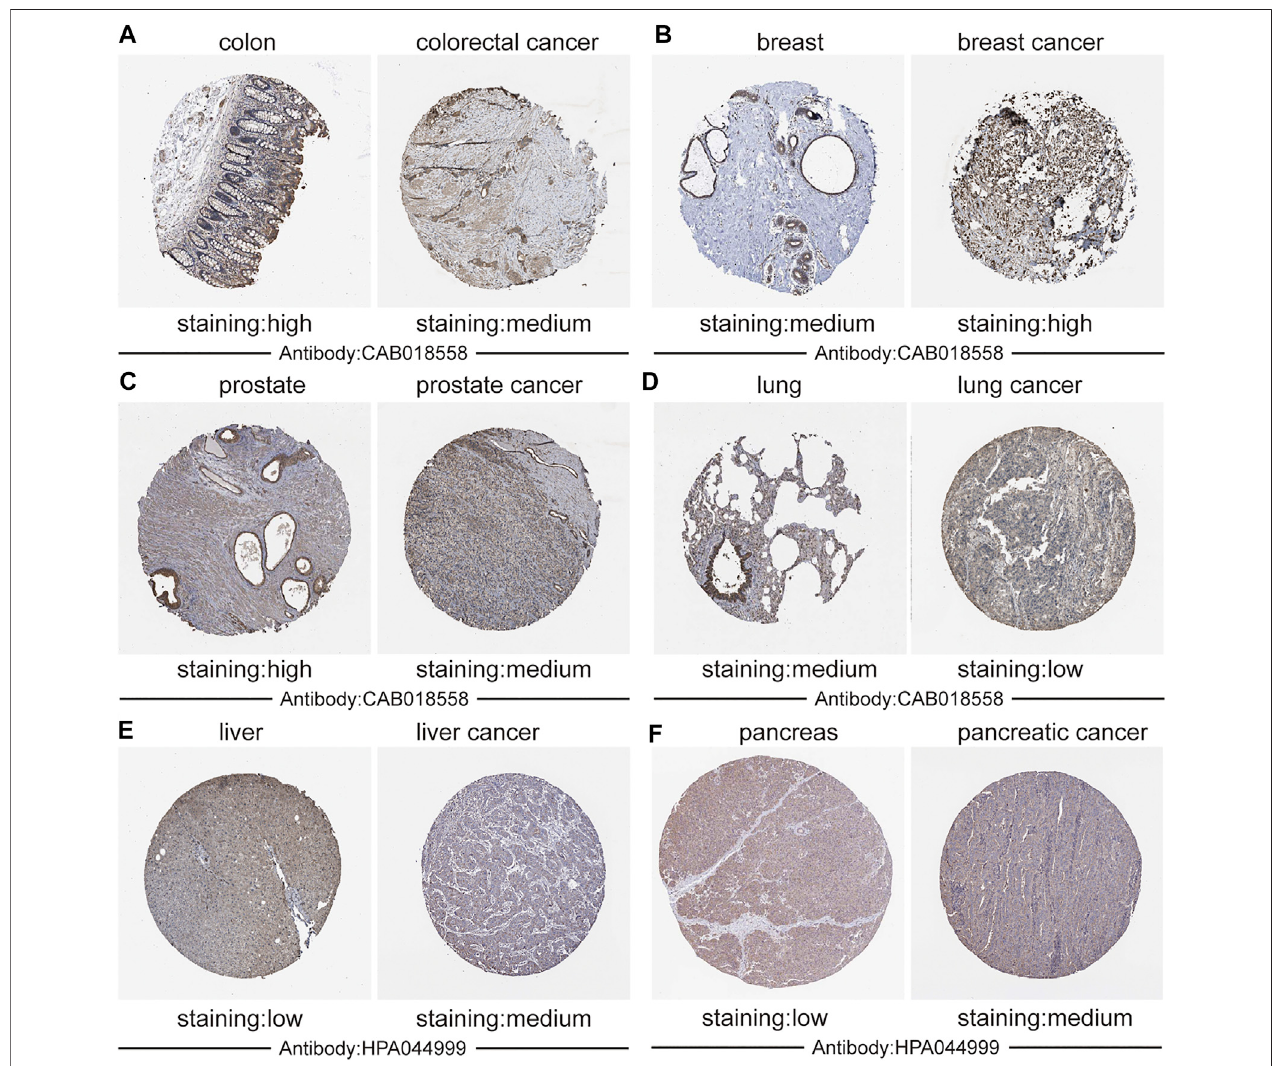
FIGURE 2 | Validation the expression of CALM1 on translational level using immunohistochemistry from the Human Protein Atlas database. (A) Colon and colorectal cancer. (B) Breast and breast cancer. (C) Prostate and Prostate cancer. (D) Lung and lung cancer. (E) Liver and liver cancer. (F) Pancreatic and pancreatic cancer. Staining: low, medium, and high. Antibody: CAB018558 and HPA044999.